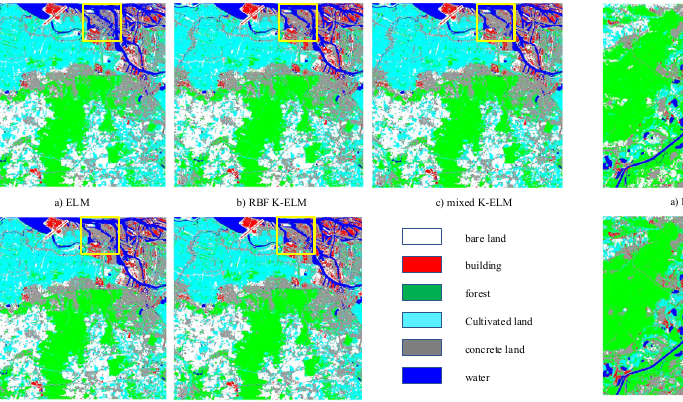
Figure 5 . Classification result of Karlsruhe dataset.